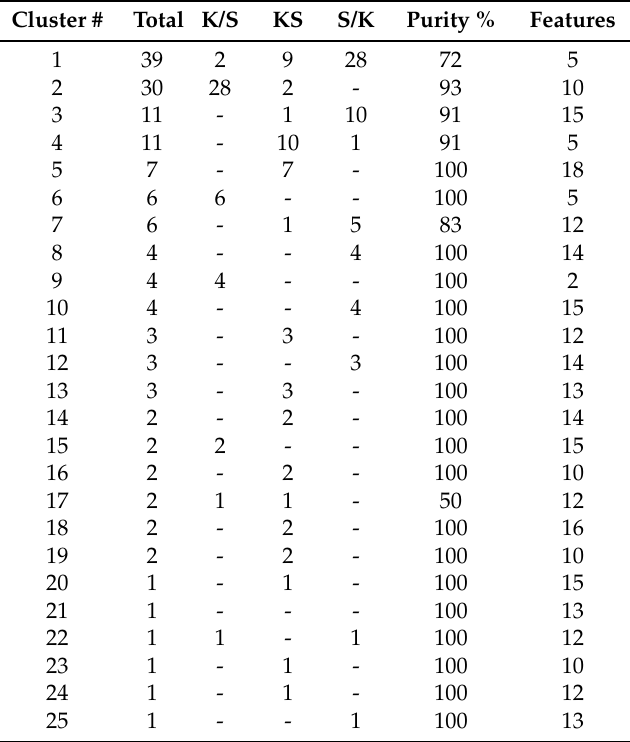
Table 4. Analysis of MACCS fingerprint performance.